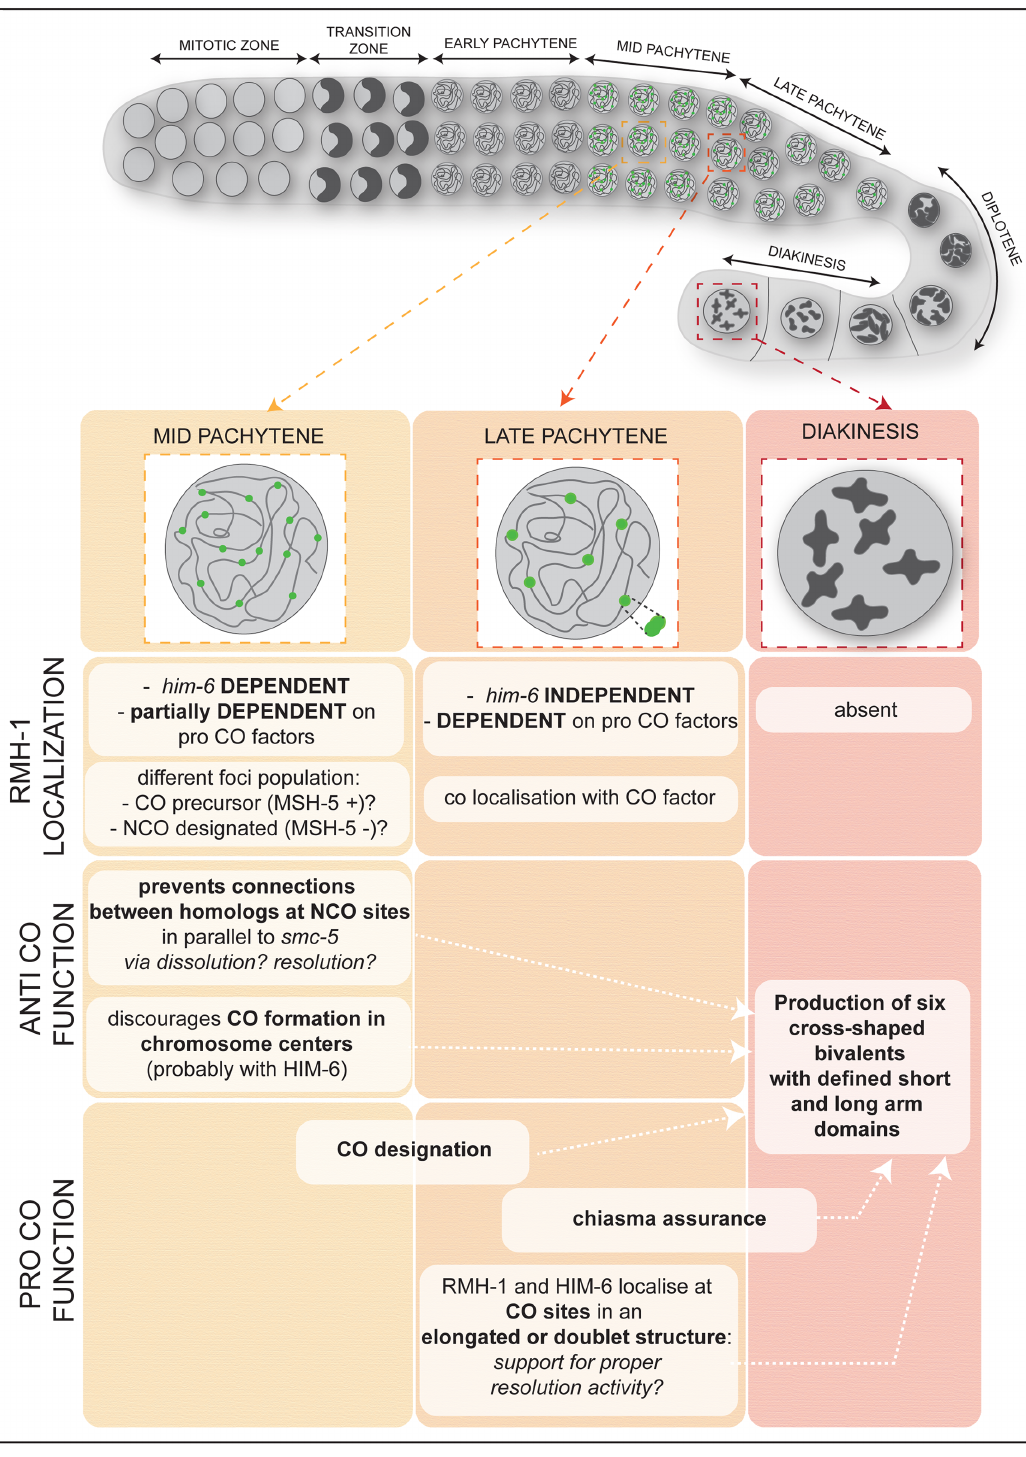
Fig 9. RMH-1 contributes to successful bivalent formation at several levels during prophase I. Top: scheme of C . elegans gonad showing prophase I divided in zones: transition zone (leptotene/zygotene), pachytene (early, mid, and late), diplotene, and diakinesis. Bottom: summary of localization and functions of RMH-1. Bold: key words referring to localization or function; italics: used when mechanistic insight is proposed. First row: localization of RMH-1: numerous foci in mid pachytene, six bright foci in late pachytene: RMH-1 is absent in diakinesis. Second row: genetic requirements and characteristics of RMH-1 localization. Third row: anti CO function: RMH-1 prevents accumulation of joint molecules and discourages CO formation in chromosome